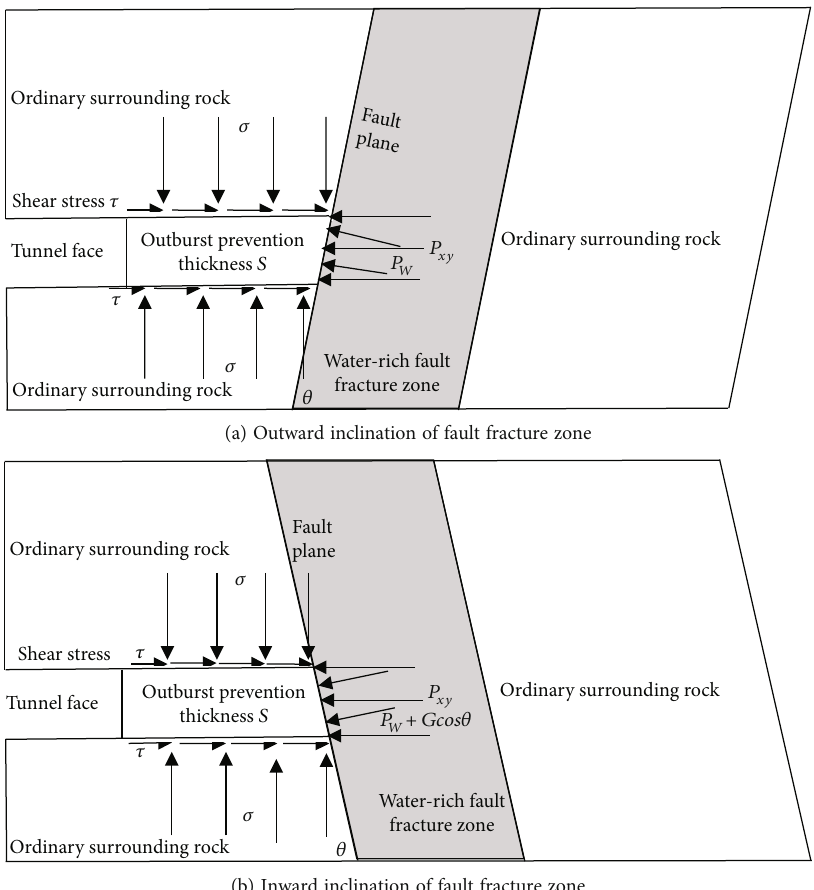
Figure 2: Mechanical model of tunnel outburst prevention rock mass.